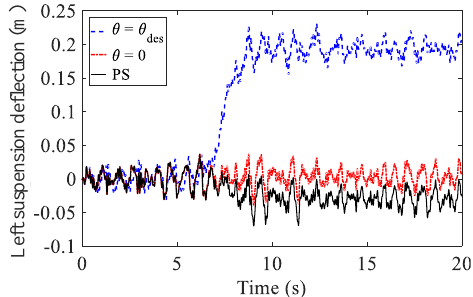
Figure 12. Left suspension deflection.